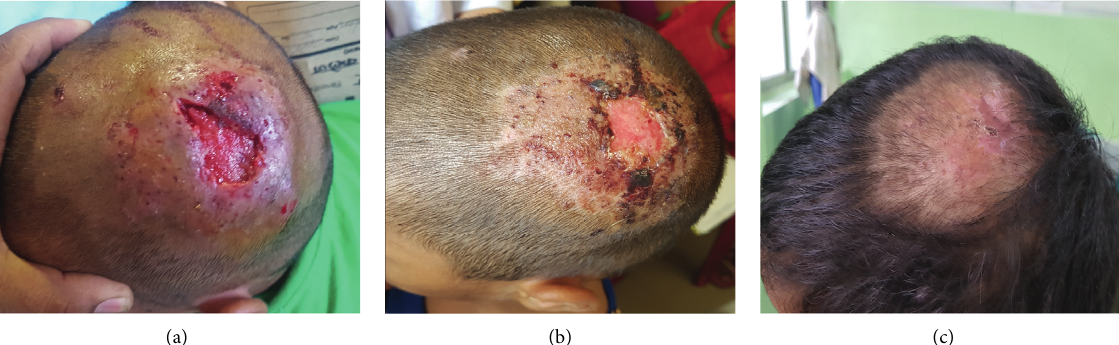
Figure 1: (a) Initial lesion of tinea capitis after surgical incision. (b) Two weeks after starting oral griseofulvin. (c) Eight weeks after starting oral griseofulvin.